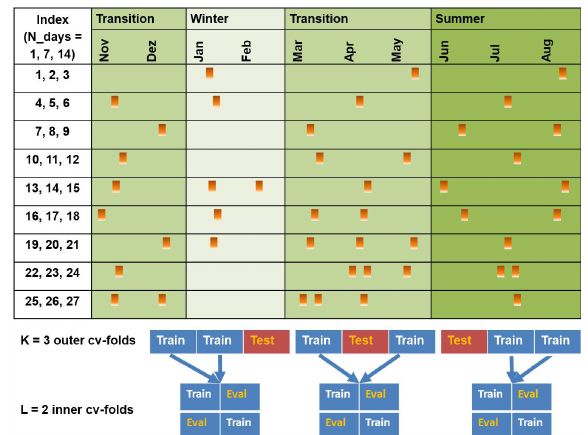
Figure 1. Sketch of the 27 survey schemes, studied in the evaluation of the regression models in a nested cross-validation setup for hyperparameter optimization and error estimation. Indices refer to the 27 scenarios with associated lengths N days of the measurement periods. The allocation of the selected measurement periods to the individual seasons (transition, summer and winter) is marked in the figure, where the distribution within the seasons is random (with 30 realizations per scenario). The cross-validation scheme is sketched exemplary for three measurement periods. Confer also